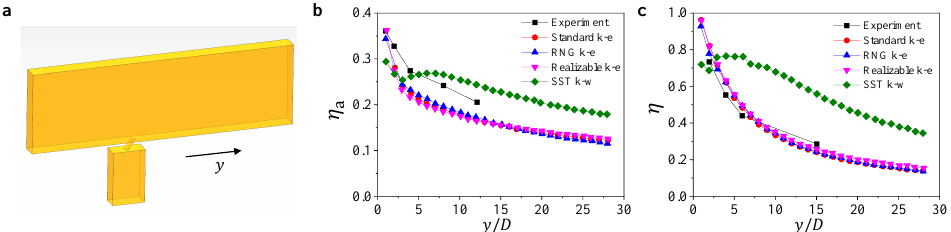
Figure 3. ( a ) Schematic of the simulation for model validation. The variation of ( b ) the averaged cooling efficiency η a in transverse direction and ( c ) the cooling efficiency η in the center line along the flow direction for simulation result and experiment data from reference